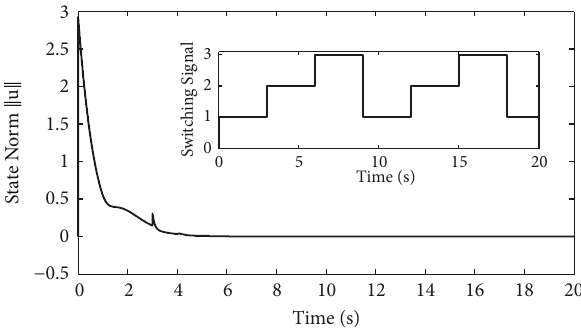
Figure 6: State norm curves of system